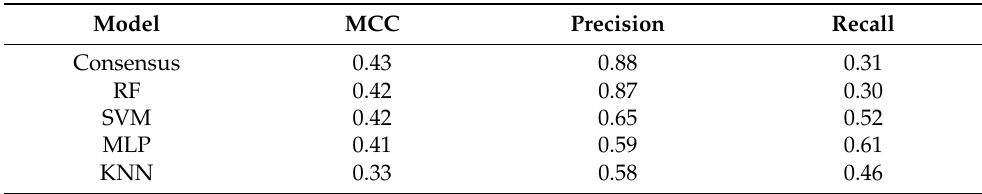
Table 1. Performance evaluation results, based on test set prediction, obtained with the 4 top-scored models and consensus strategy.